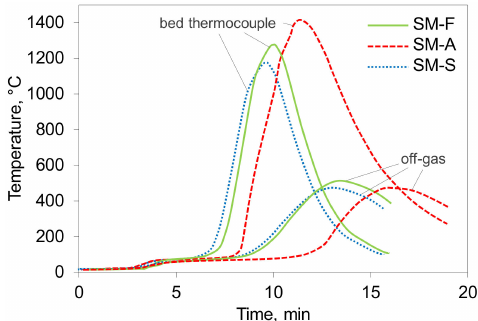
Figure 2. Temperature profiles recorded during pot sintering. Higher curves apply for the thermocouple in bed and lower for